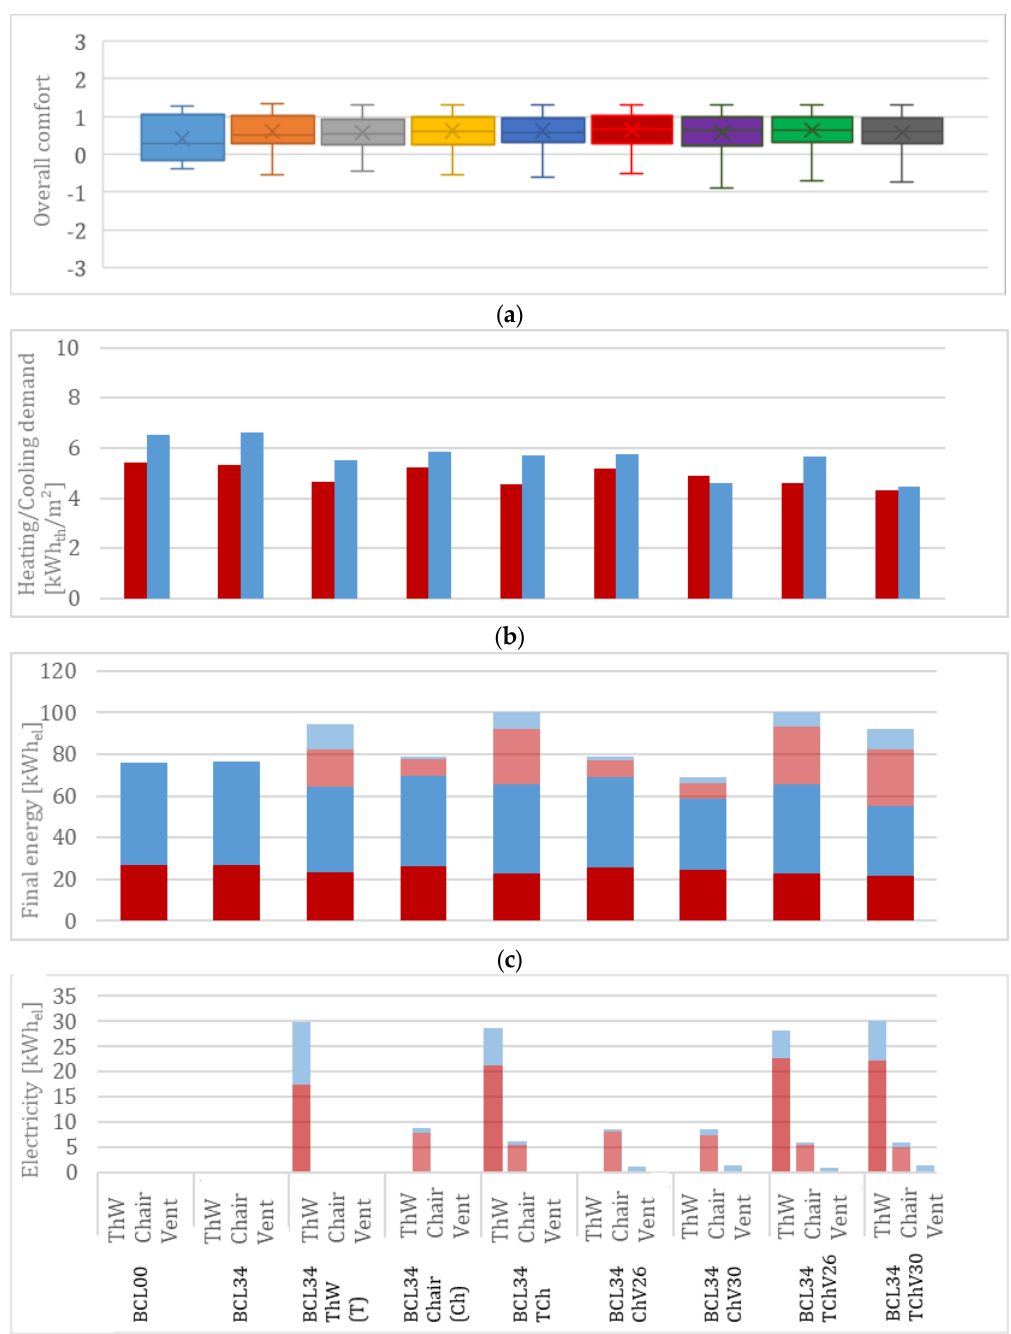
Figure 16. Spring (15.03 – 15.05): ( a ) Overall comfort values for the different controllers (n = 5856), ( b ) Thermal Hheating and cooling demand [kWhth/m²], ( c ) Used electrical end energy for heating and cooling with consideration of a reversible heat pump (COPHeating = 3, COPCooling = 2) and used energy for the decentralized systems [kWhel], ( d ) Electrical eEnergy of the decentralized systems, thermoelectric wall (ThW), chair (Ch), fan (V) [kWhel]. ;